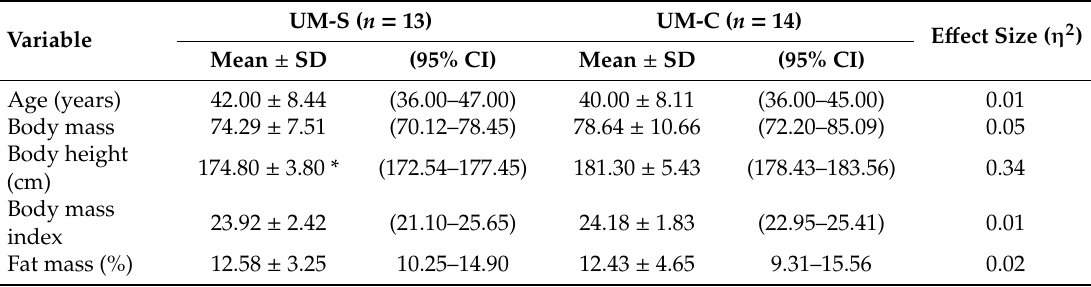
Table 1. Characteristics of the participants ( n =